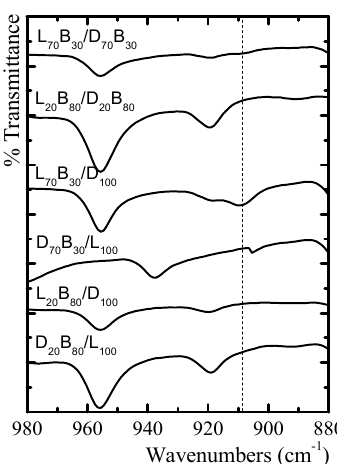
Figure 10. Infrared spectrum of the PLA stereocomplexes. Sensitive bands to the formation of PLA stereocomplexes. The dashed line indicates the position of the 909 cm − 1 band.